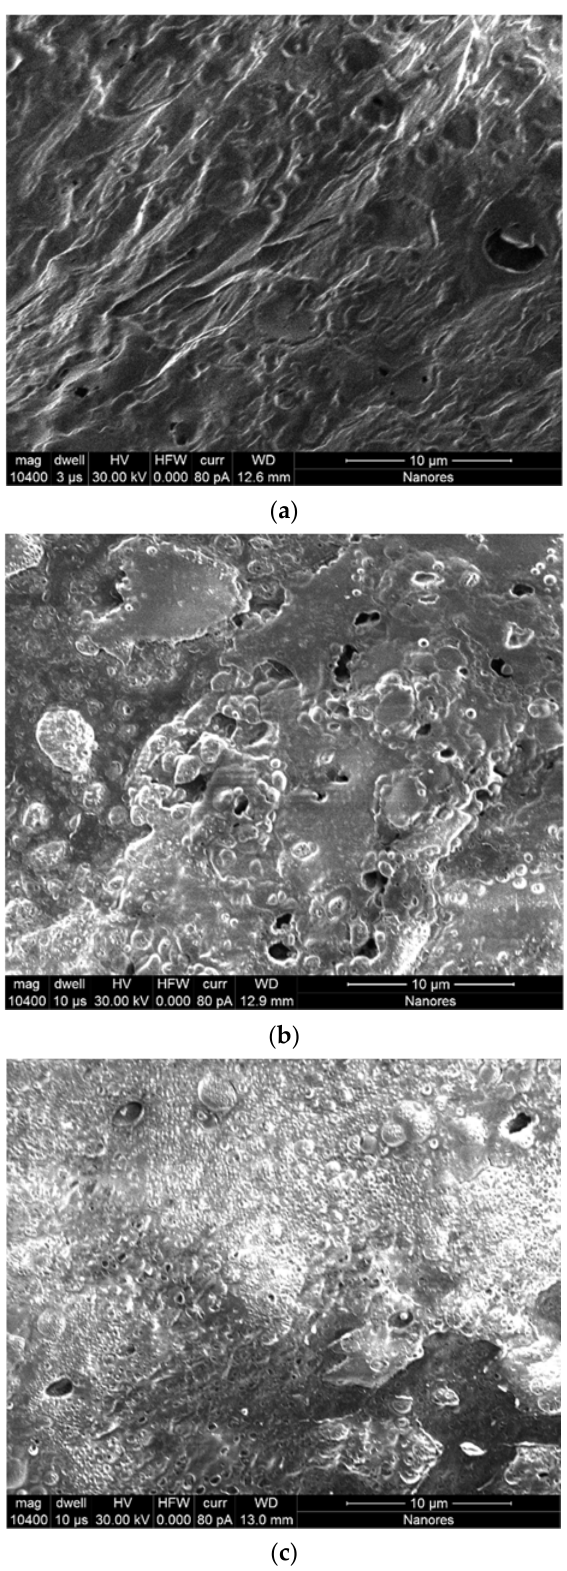
Figure 1. Sample SEM images of hydrogel materials based on gelatin (G) and polyvinyl alcohol (PVA). Gelatin-based hydrogel without PVA (G/PVA 0%) ( a ); gelatin-based hydrogel with 1% w / v of PVA (G/PVA 1%) ( b ); and gelatin-based hydrogel with 2% w / v of PVA (G/PVA 2%) ( c ). In each case, the concentration of gelatin was 10% w / v .